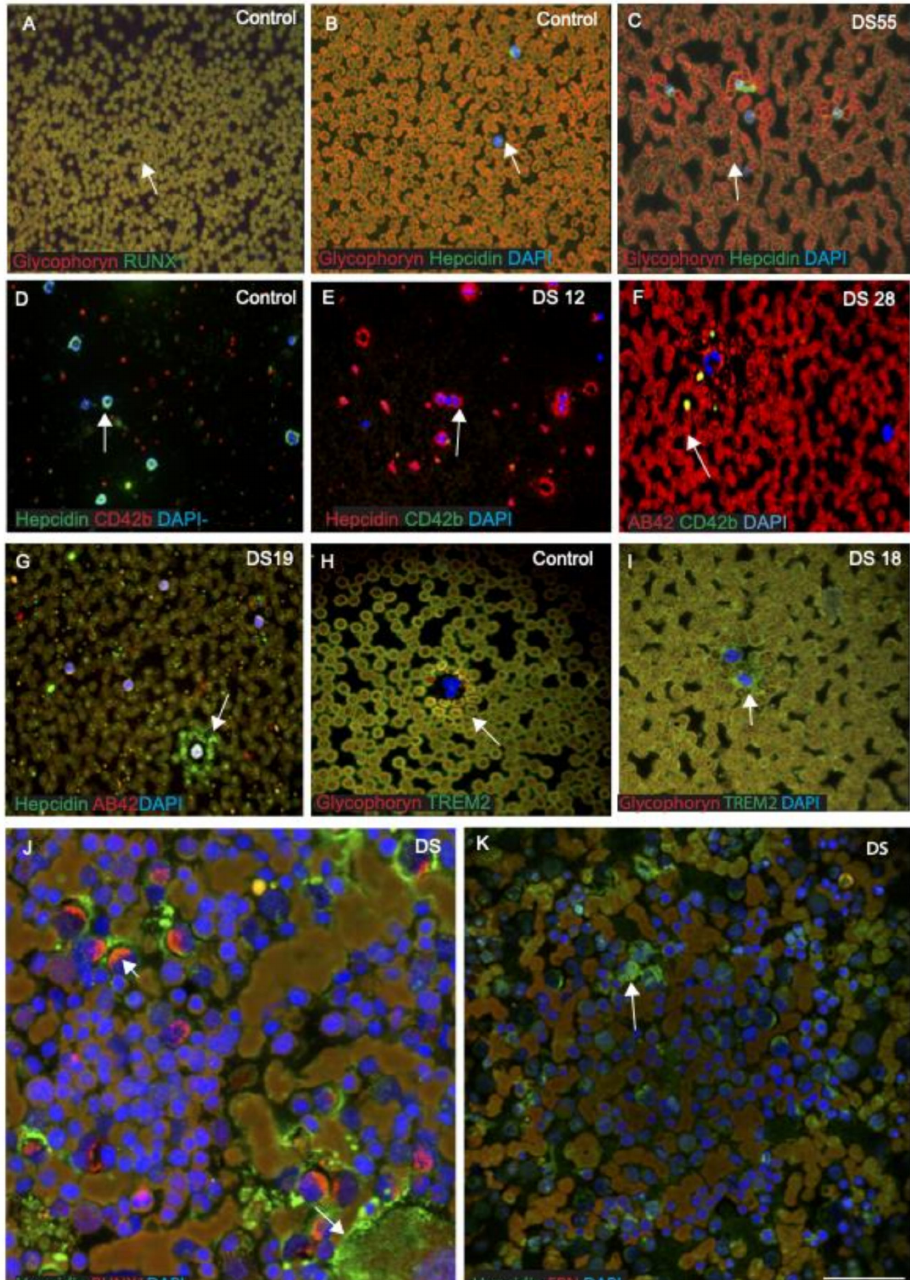
Figure 8. RUNX1 and hepcidin were observed in the erythro-megakaryocytes and platelets, suggesting a myeloid